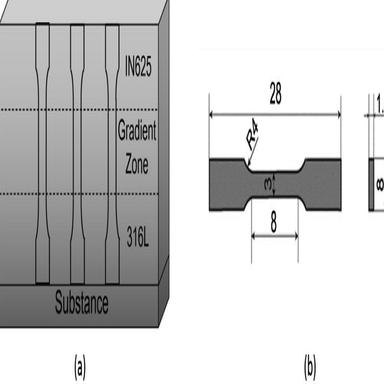
The tensile specimens design scheme for tensile tests: (a) The position of tensile specimens. (b) Geometry of tensile specimens in mm.